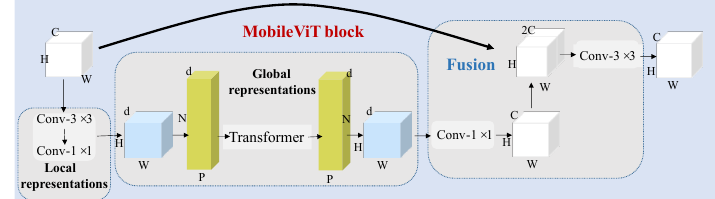
Figure 3. Structure of the MobileViT